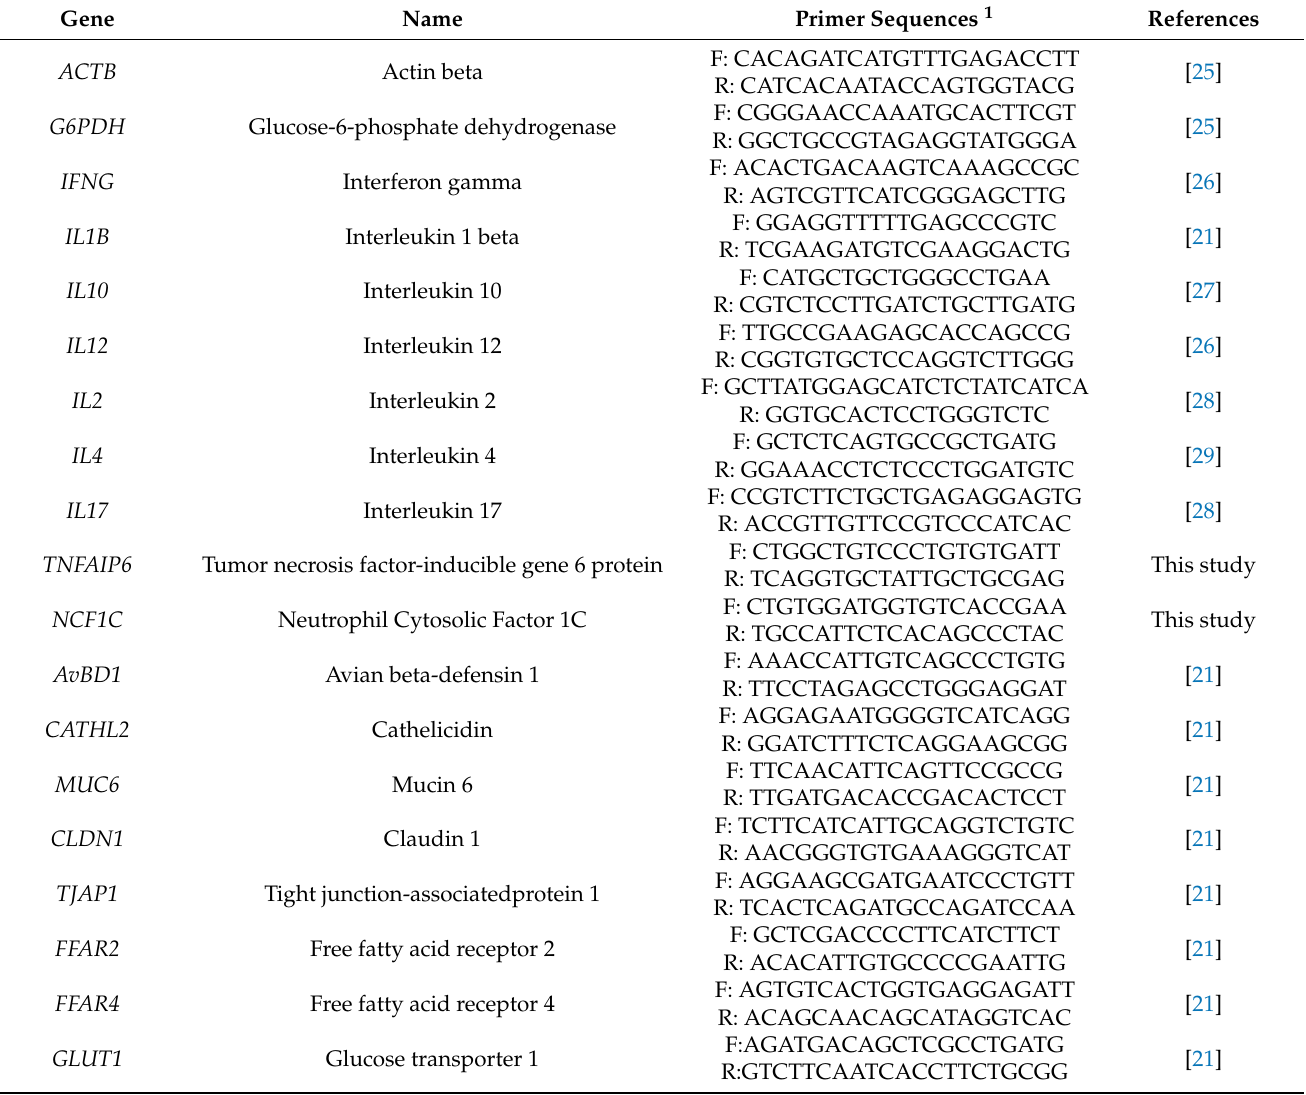
Table 2. Primer sequences used in RT-qPCR